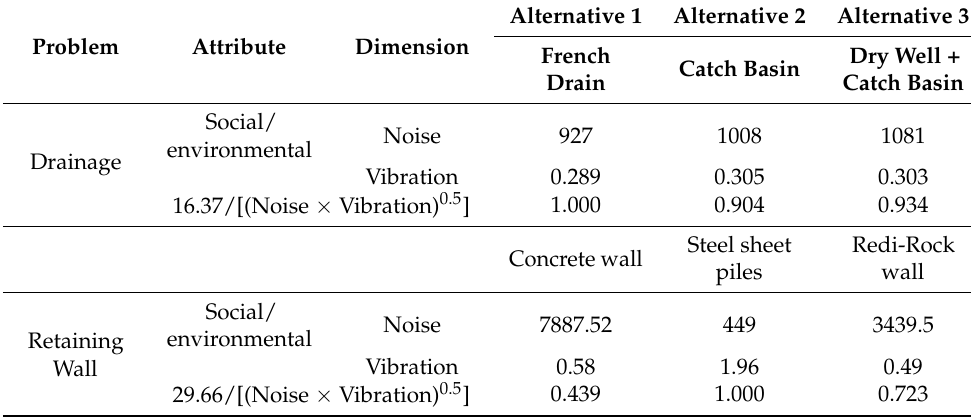
Table 11. Social/environmental